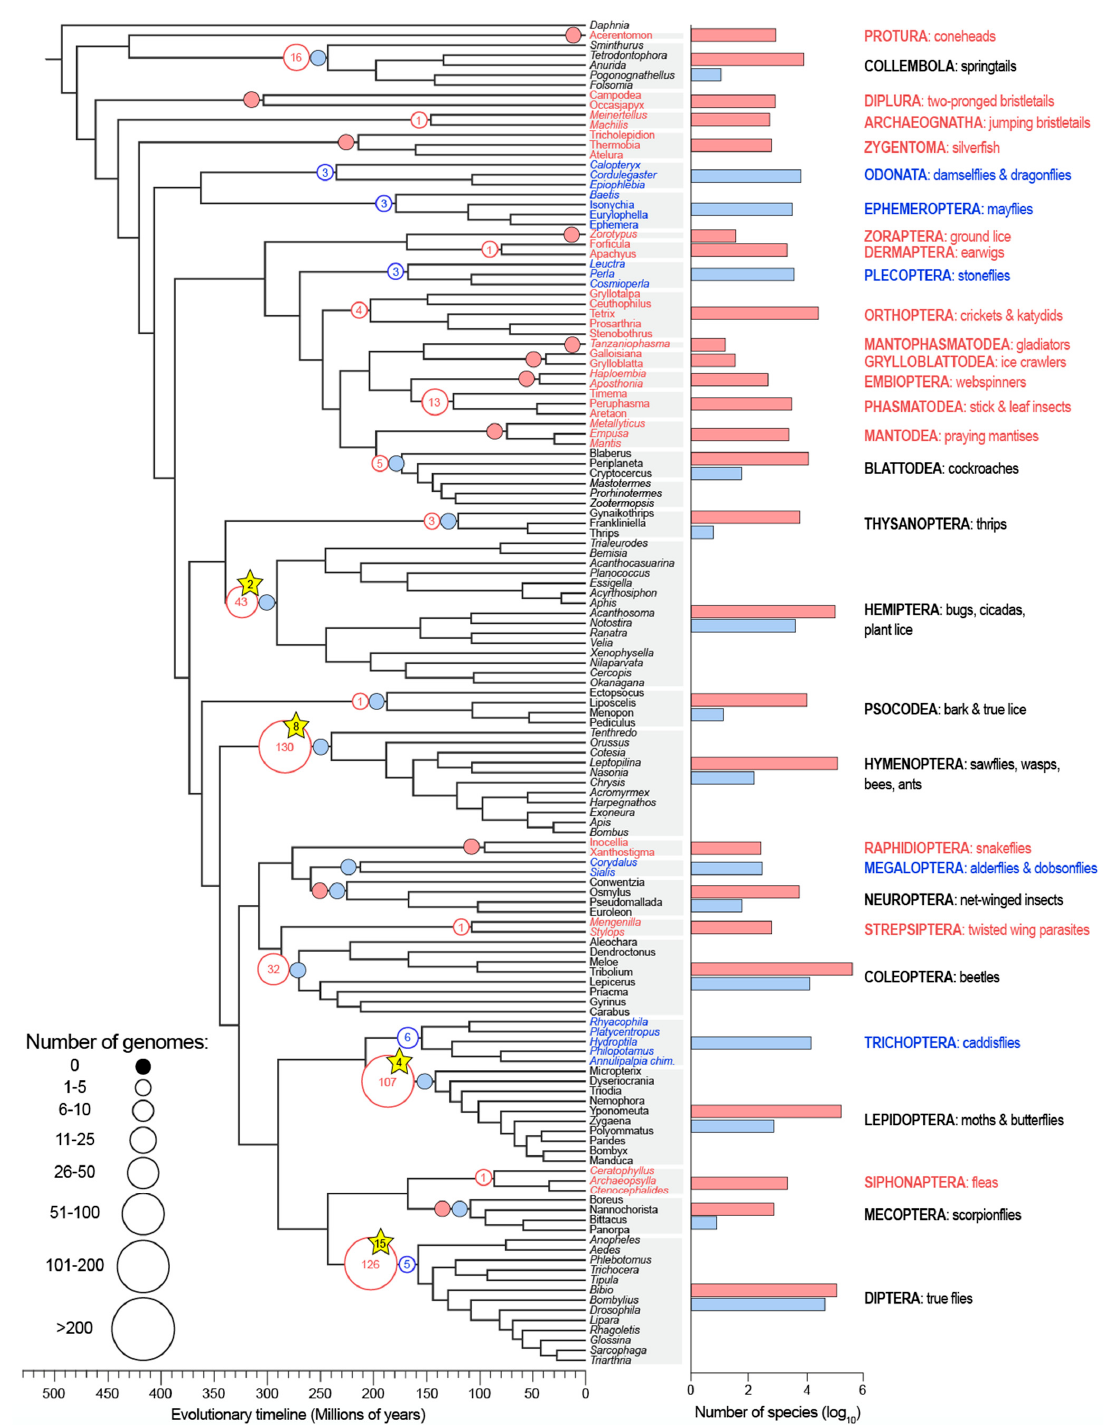
Figure 1. A dated phylogeny of evolutionary relationships among major insect taxonomic groups with the availability of genomic resources for each lineage overlaid. The size of each circle represents the number of available nuclear genomes and their color corresponds to life history strategy, either terrestrial (red) or aquatic (blue). To the right of the tree, the number of described species per group are shown on a log 10 scale. Groups that include both terrestrial and aquatic species (e.g., Collembola) are in black font with diversity given separately for terrestrial (red) and aquatic (blue) species.